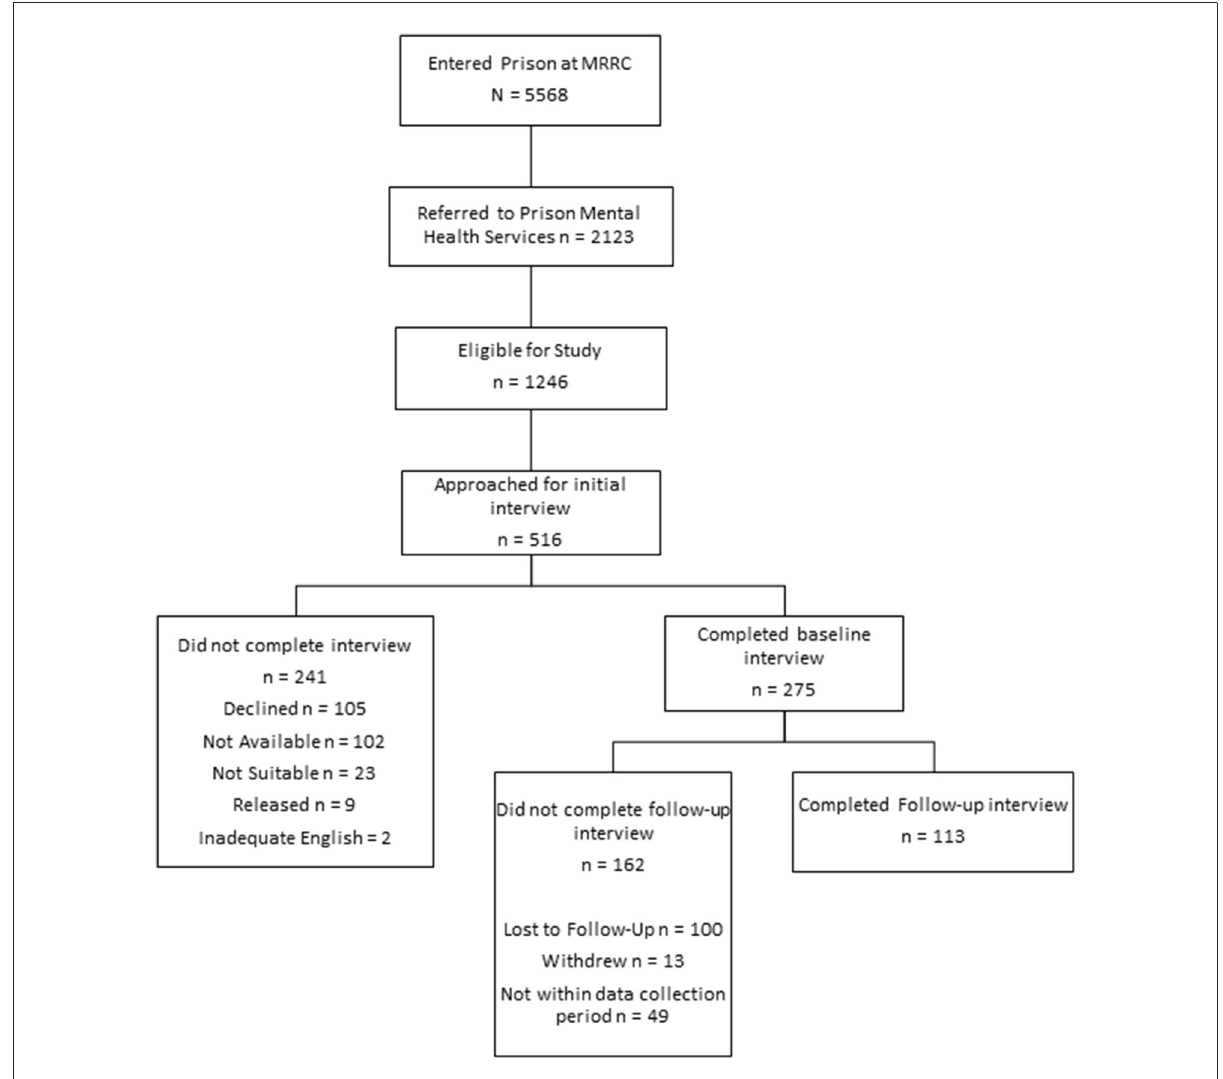
FIGURE1 Participant recruitment